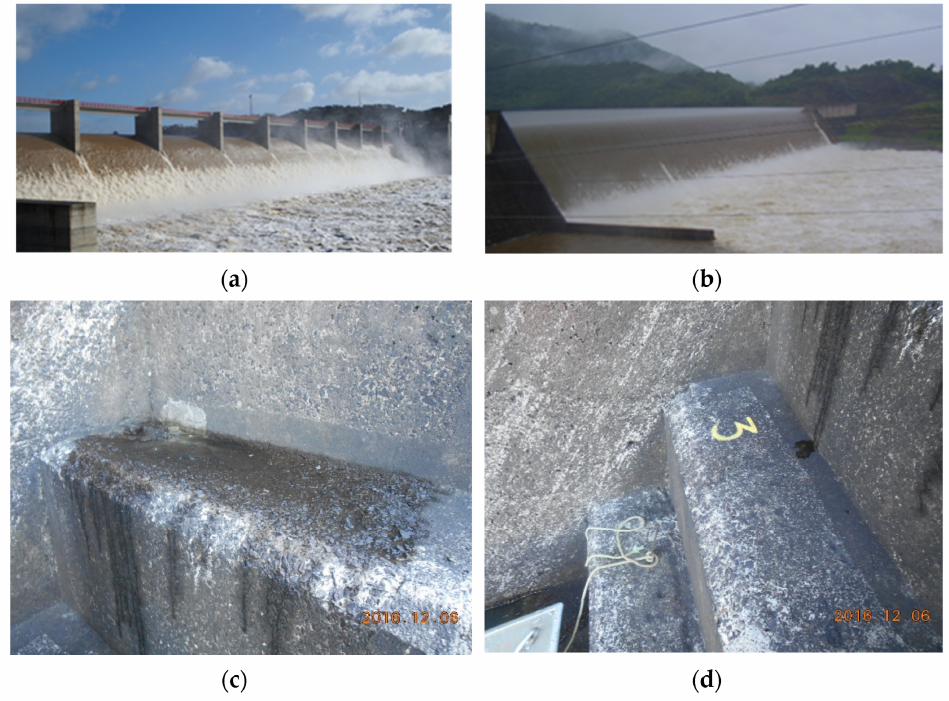
Figure 1. Pedr ó g ã o ( a ) and Dona Francisca ( b – d ) dam spillways: ( a , b ) in operation, for discharges lower than those corresponding to design conditions, in particular for Pedr ó g ã o: ( c , d ) some damaged steps of the Dona Francisca dam, after a major flood event in December of 2010; ( a ) courtesy Jorge Vazquez, EDIA; ( b – d ) courtesy Dona Francisca Energ é tica